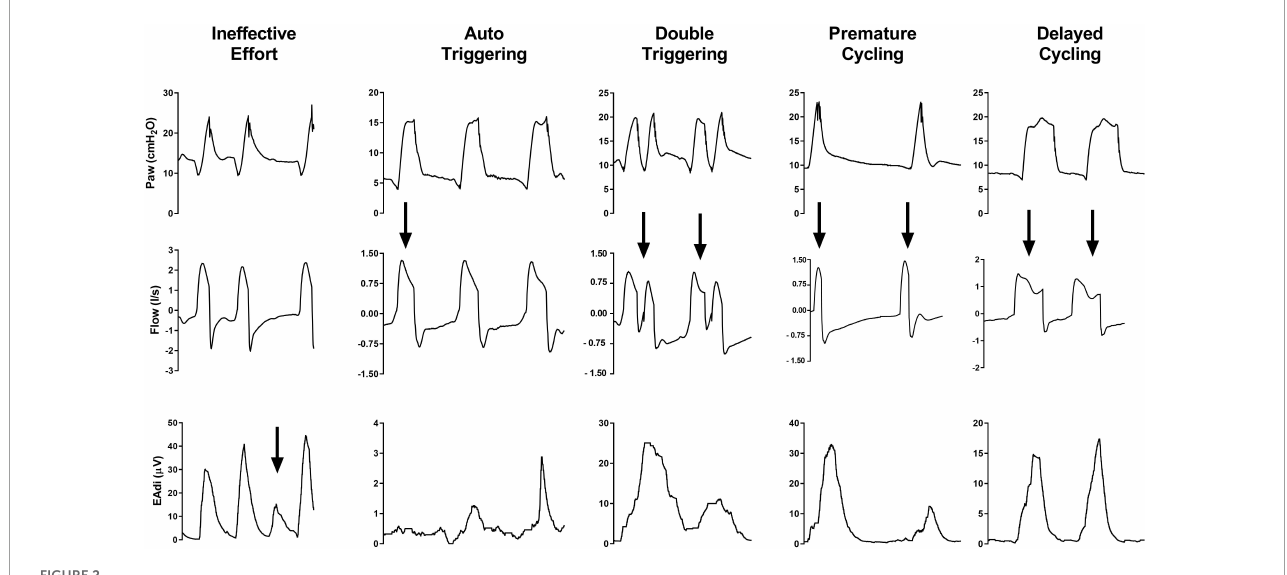
FIGURE2 From top to bottom, waveforms of airway pressure (Paw), flow, and electrical activity of the diaphragm (EAdi) are depicted for each type of patient–ventilator asynchronies. Arrows highlight the asynchronous